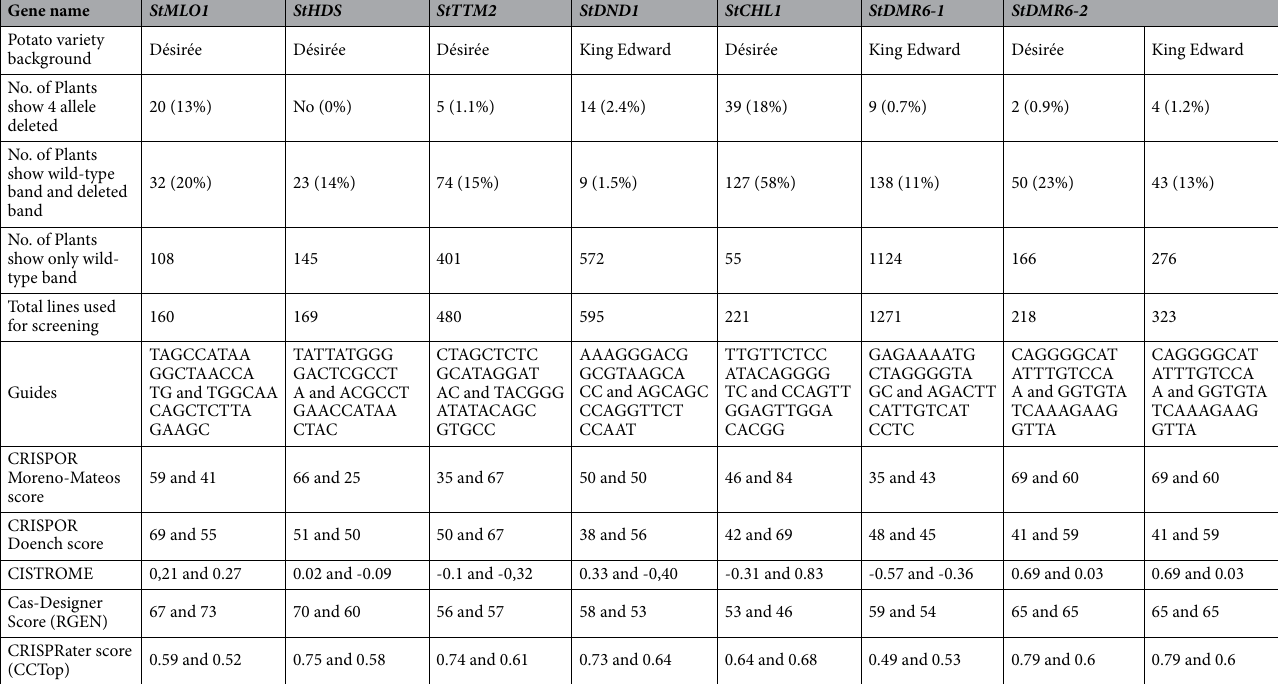
Table 2. Summary of screening of deletion mutants in this study.